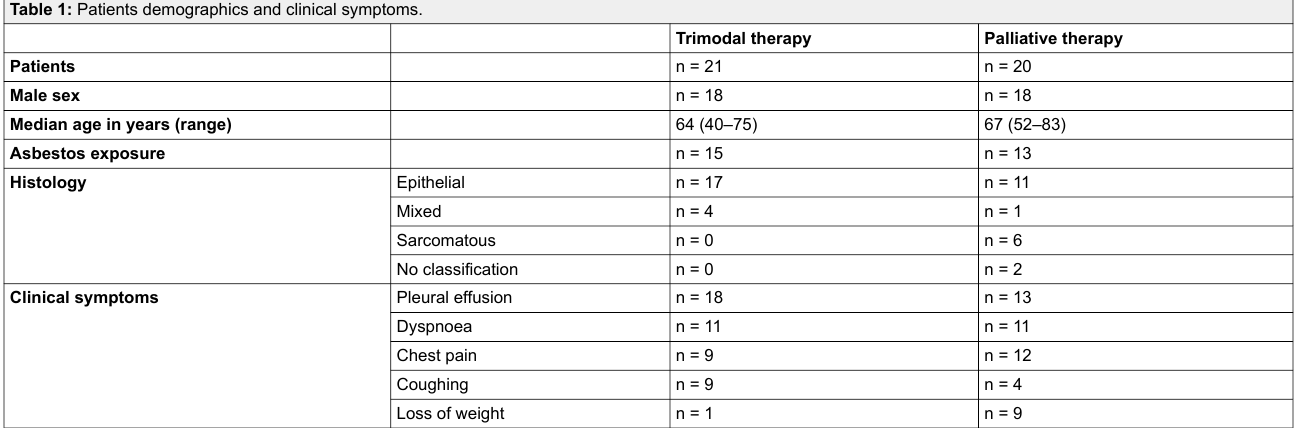
Table 1: Patients demographics and clinical symptoms.